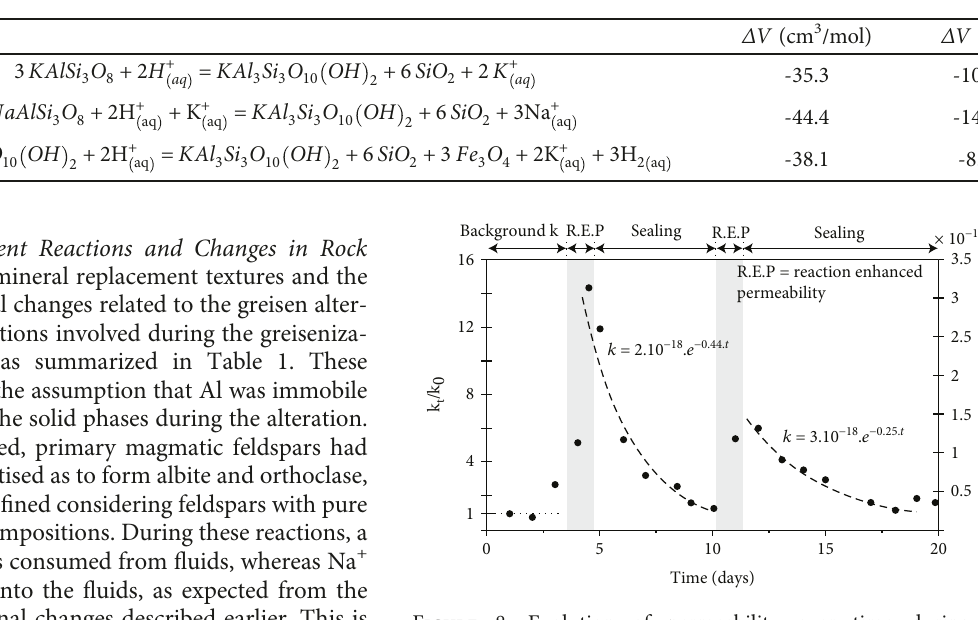
Table 1: Molar volume changes ( Δ V ) induced by the replacement reactions related to the greisen alteration of the least altered Panasqueira granite. Δ V (cm 3 /mol) are calculated at 400 ° C and 100 MPa using the thermodynamic database SUPCRTBL. Δ V (%) is the molar volume change relative to the molar volume of the reactant minerals.